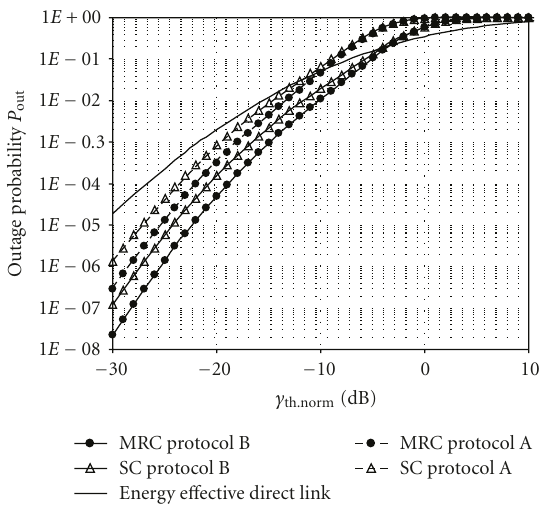
Figure 2: Outage probability versus rate-normalized threshold of the cooperative diversity system using MRC and SC under both multiple access protocols, compared to the reference direct link